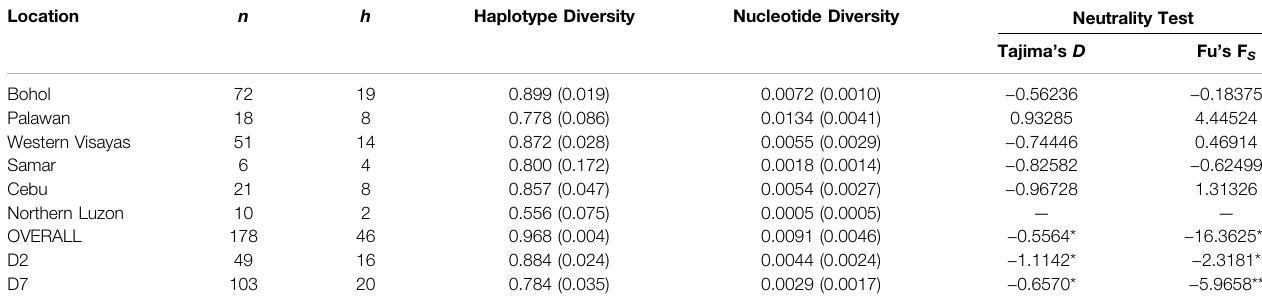
TABLE 2 | Genetic diversity indices and values of neutrality test statistics of Philippine pigs including the predominant D2 and D7